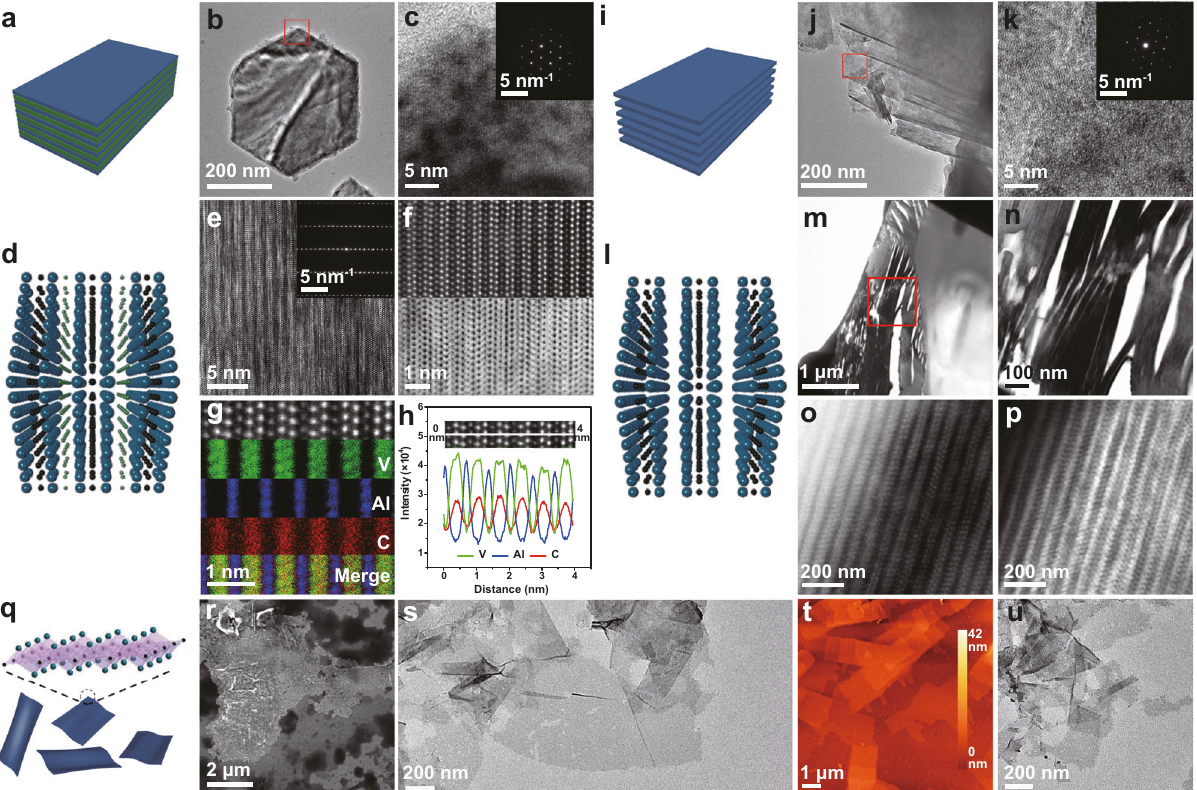
Fig. 3 Structural and compositional characterizations of V 2 AlC MAX and V 2 C MXene. a Schematic of V 2 AlC structure. Top view of b low and c high magni fi cation (Inset describes the corresponding SAED pattern) TEM images of V 2 AlC. d Atomistic model of layer structure showing in-plane chemical ordering in V 2 AlC MAX phase. e HRSTEM image (Inset illustrates the corresponding SAED pattern) and f enlarged HRSTEM images (upper presents HAADF image and lower presents ABF image) of V 2 AlC. g HRSTEM with corresponding EDX mapping of V, Al, and C element signals of V 2 AlC along [001] zone axis. h EDX linear-scanning pro fi le of V, Al, and C element over the white line marked in the HAADF image. i Schematic of ML V 2 C MXene. Top view of j low and k high magni fi cation (inset exhibits the corresponding SAED pattern) TEM images of ML V 2 C MXene. l Atomistic model of layer structure elucidating in-plane chemical ordering in ML V 2 C MXene. m , n Overview cross-sectional HRSTEM micrograph of ML V 2 C MXene after HF selective etching of Al. o HAADF and p ABF image of ML V 2 C MXene. q Schematic of FL V 2 C MXene. r FESEM, s TEM, and t AFM image of FL V 2 C MXene after intercalation with TPAOH. u TEM image of FL V 2 C MXene after sonication. A representative image of three replicates from each group is